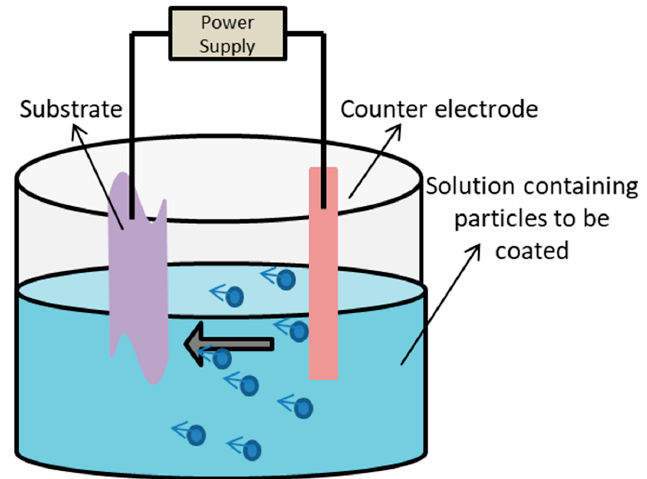
Figure 18. Schematic representation of electrophoresis cell showing movement of coating particles towards the substrate in the presence of electric field.